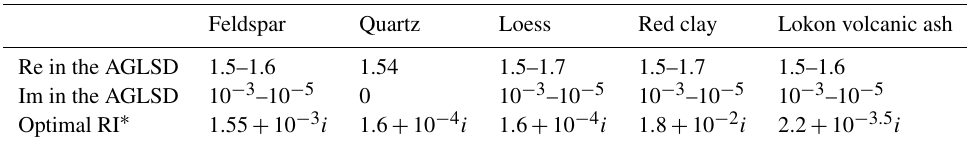
Table 1. The estimated refractive index (RI) values given by the Amsterdam–Granada Light Scattering Database (AGLSD) and the RIs corresponding to our optimal numerical results.